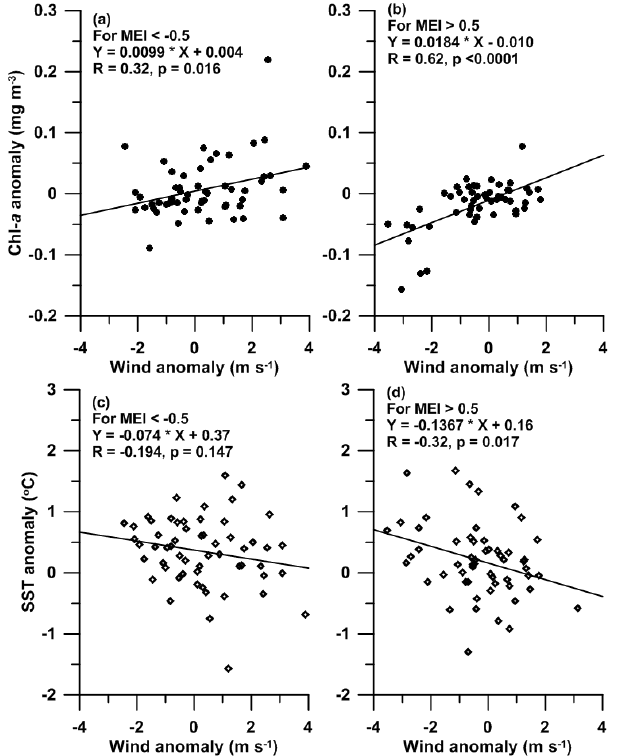
Fig. 12. The correlation between anomalies of Chl and wind speed under La Niña (a) or El Niño conditions (b) and between anomalies of SST and wind speed under La Niña (c) or El Niño conditions (d) .